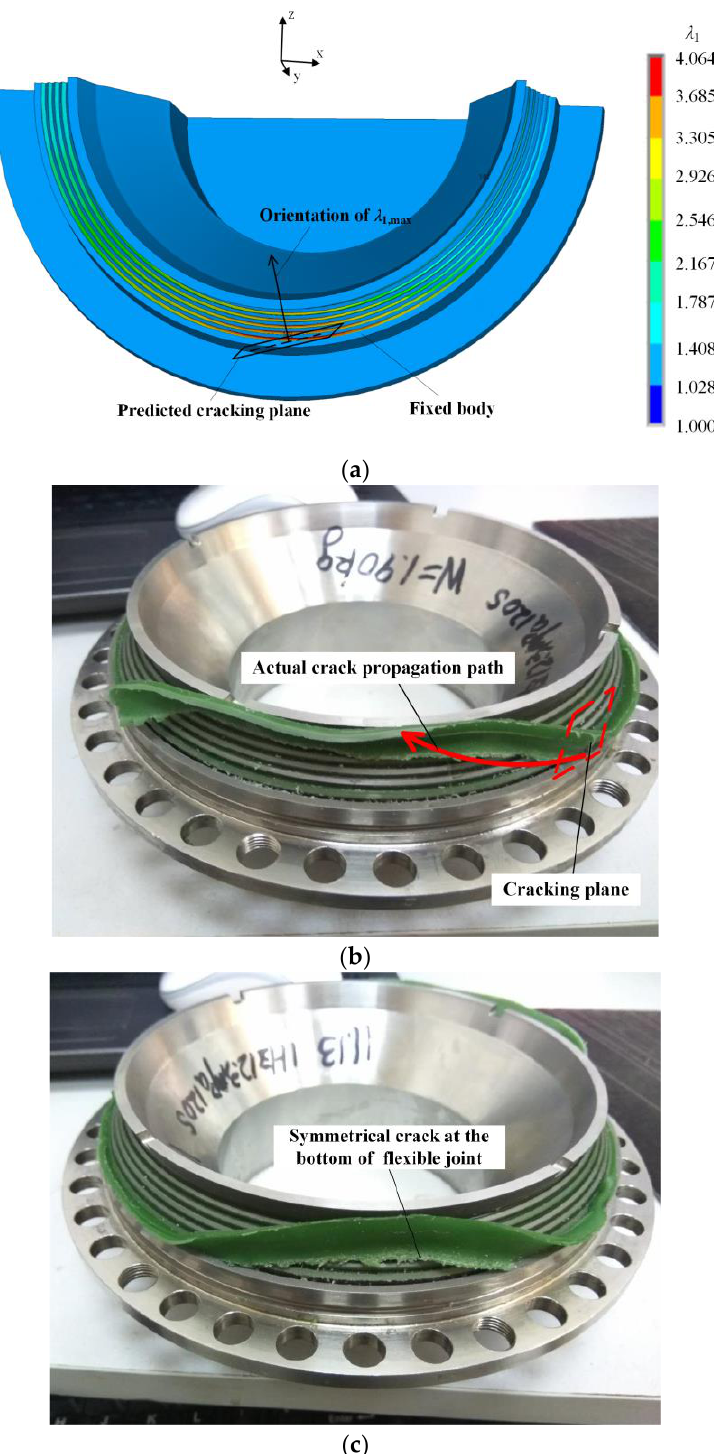
Figure 14. Comparison between actual failure position and predicted failure position in fatigue life test of the flexible joint: ( a ) Predicted cracking orientation; ( b ) actual cracking propagation path; ( c ) symmetrical side at the bottom of flexible joint after swing fatigue test.